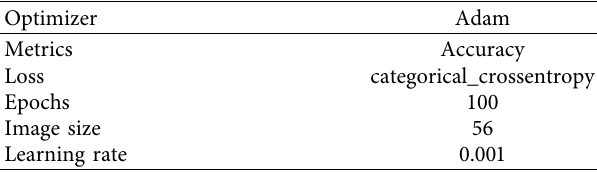
Table 3: Different hyperparameters used.